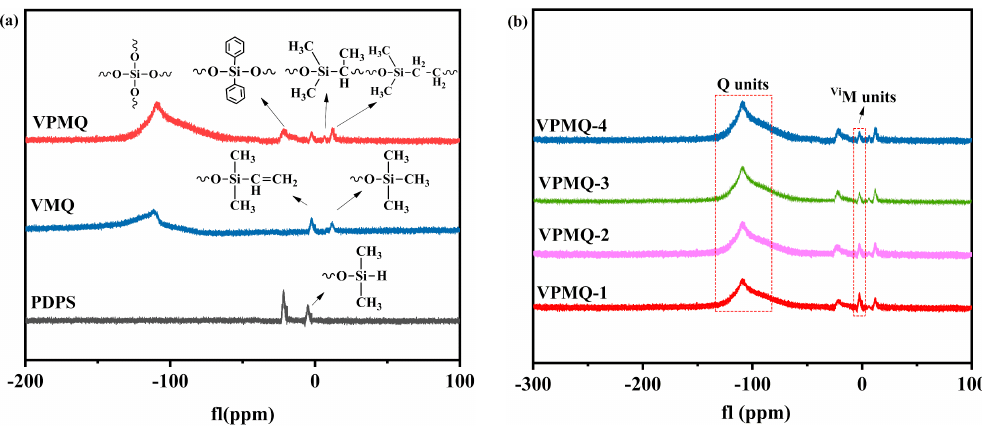
Figure 4. ( a ) 29 Si NMR spectra of VMQ, VPMQ and PDPS. ( b ) 29 Si NMR comparison of VPMQ samples.